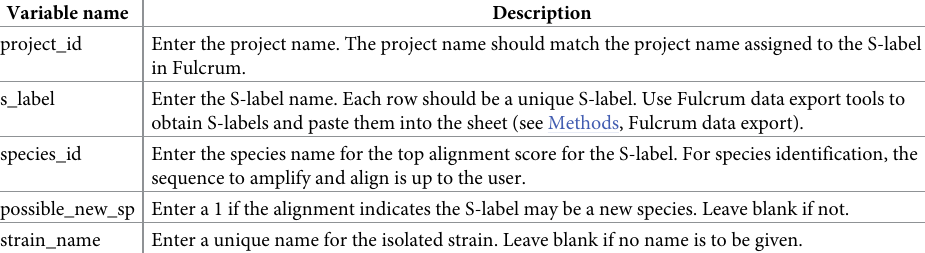
Table 2. Description of the general genotyping sheet